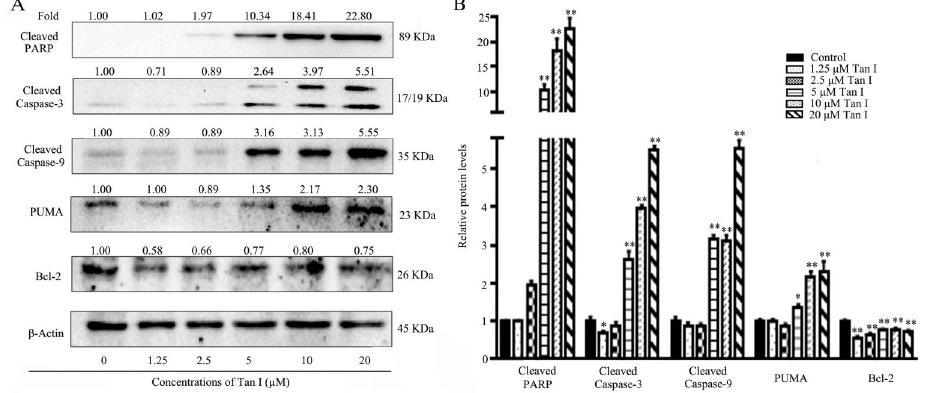
Figure 2. Effects of apoptosis-related protein in K562 cells after the treatment of Tan I. A , Protein expression of cleaved caspase 3/9, cleaved PARP, PUMA, and Bcl-2 were analyzed by western blot. B , The protein expression levels were quanti fi ed by Image Lab software. Data are reported as means ± SD. *P o 0.05 and **P o 0.01 compared with the corresponding control group